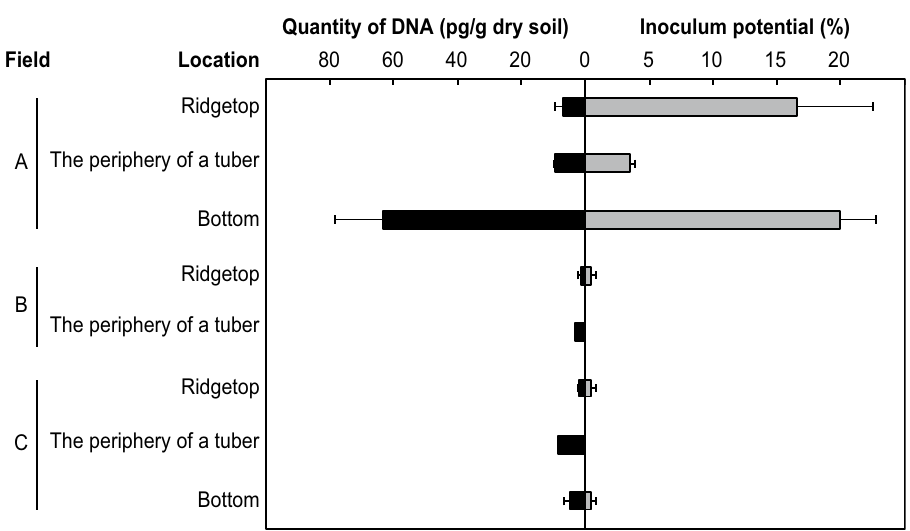
Figure 5. Quantities of P. infestans DNA and inoculum potential from soils in commercial fields. Bars indicate the standard error. Fields A, B, and C indicate separate potato fields in the Tokachi region, Hokkaido,